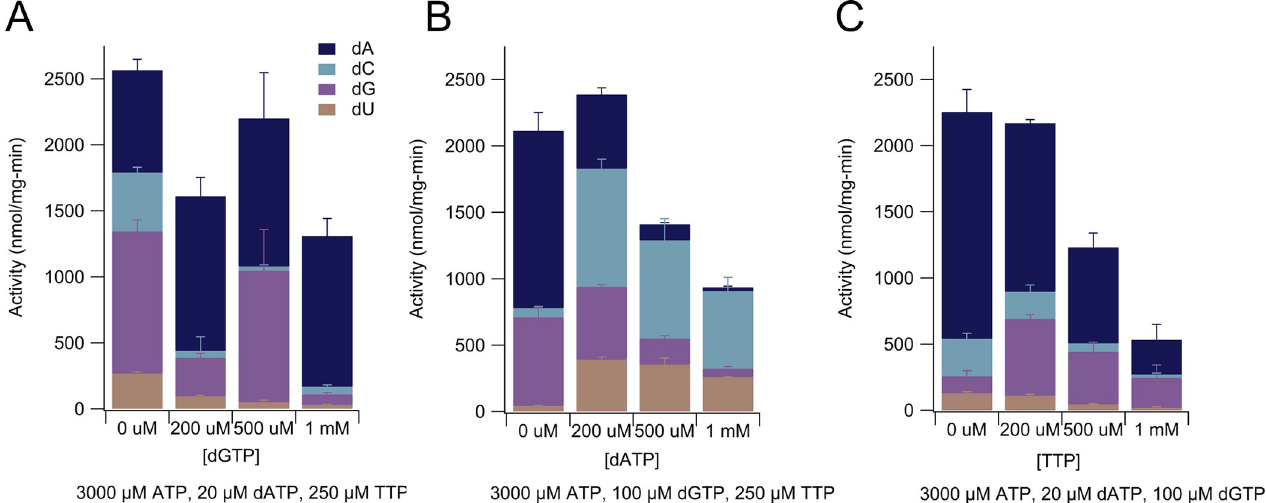
Fig 8. Assay data with class Ia E . coli ribonucleotide reductase measuring the reduction of all four ribonucleotide substrates simultaneously. (A) Activity of Ec NrdA in the presence of substrates, effectors, and varying amounts of dATP. (B) Activity of Ec NrdA in the presence of substrates, effectors, and varying amounts of dGTP. (C) Activity of Ec NrdA in the presence of substrates, effectors, and varying amounts of TTP. Each bar is representative of the average activity +/- standard error of the mean for three replicates. The values of each bar are shown in Table 2. Except for the indicated concentrations of allosteric effectors on the X-axis, components and concentrations were as follows: Trx (30 μ M), TrxR (0.5 μ M), NADPH (200 μ M), CDP (70 μ M), UDP (50 μ M), GDP (200 μ M), ADP (110 μ M), NrdA (0.1 μ M dimer), NrdB (0.5 μ M dimer).